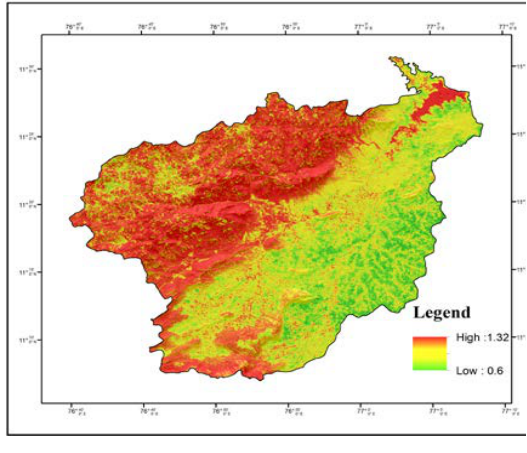
Figure 7. Cover Management Factor (C)